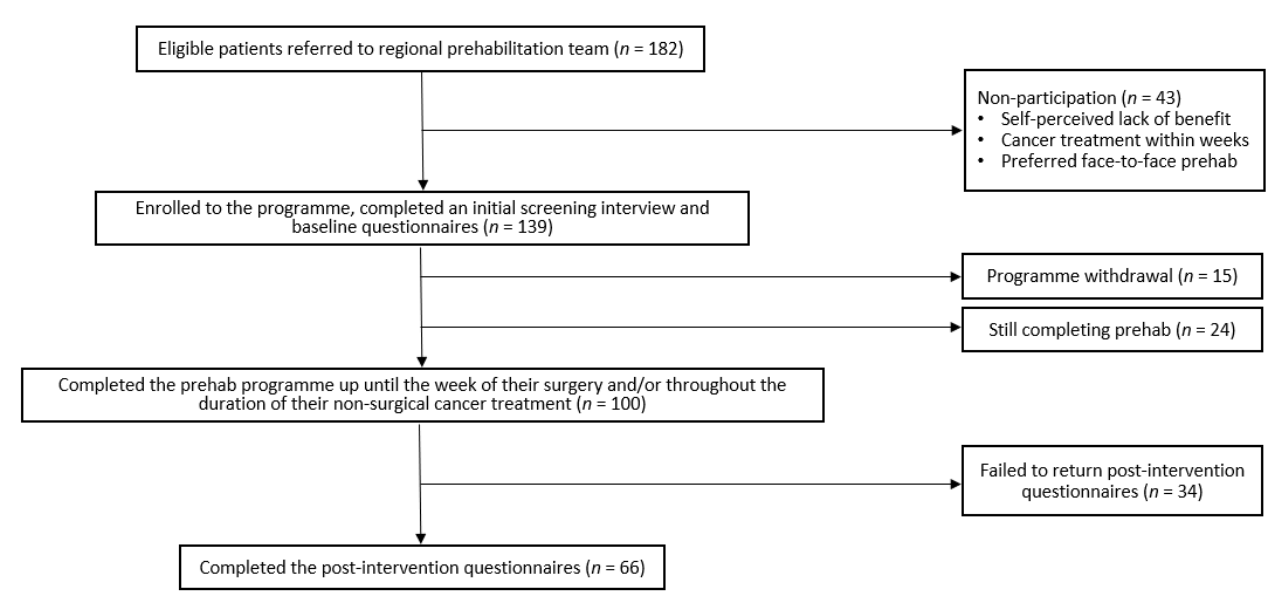
Figure 1. Patient flow chart.